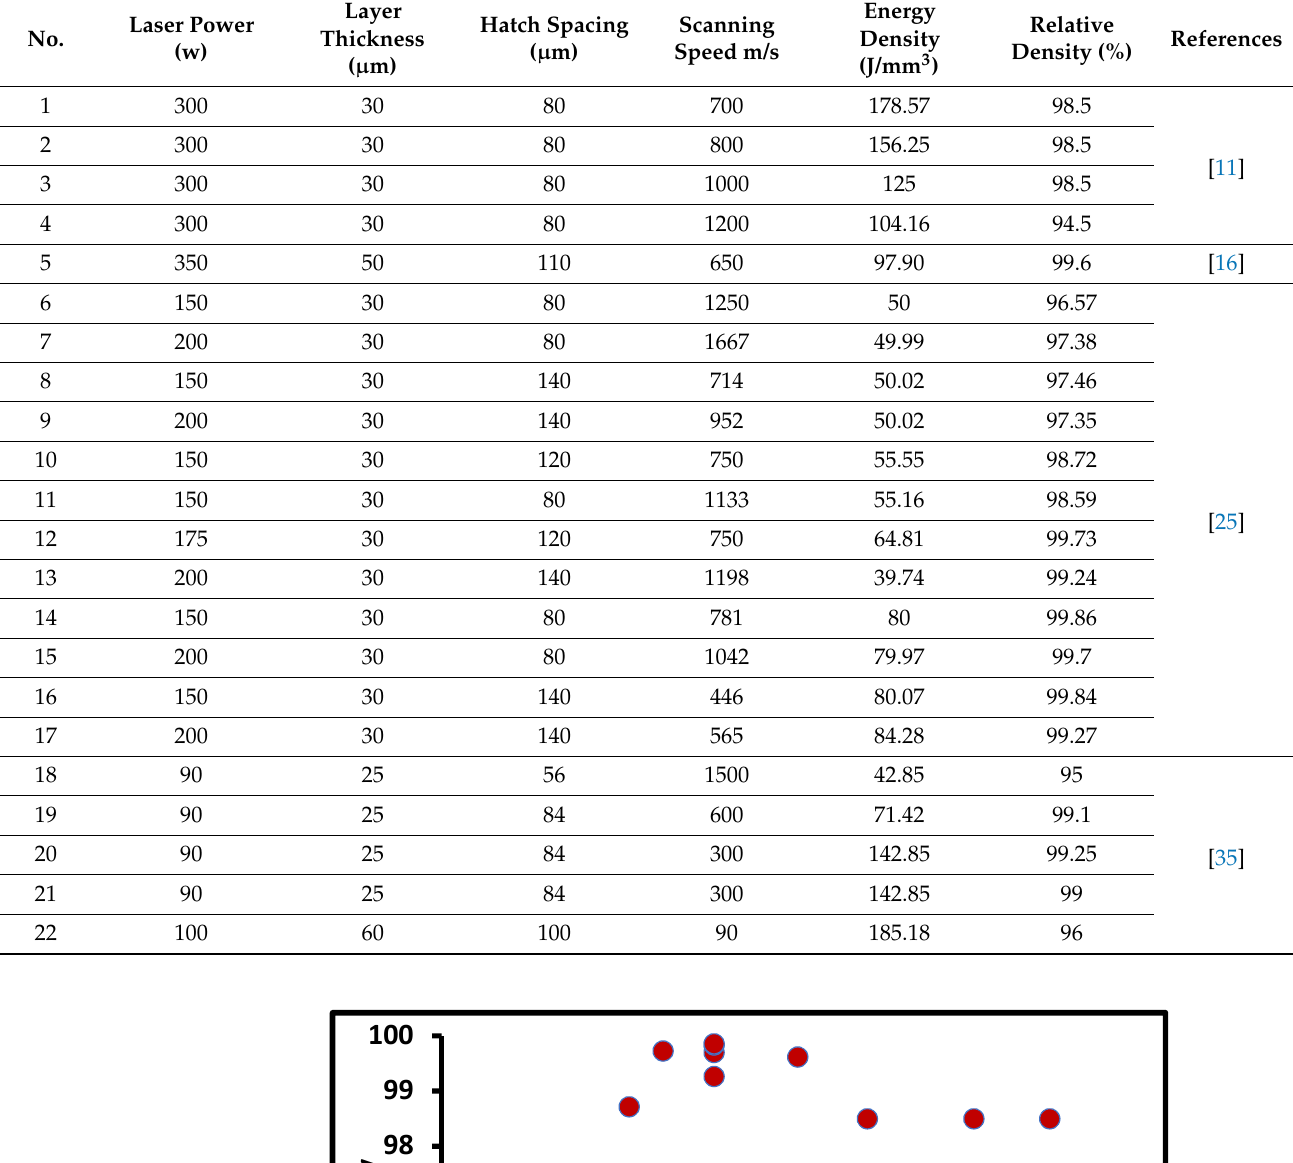
Table 3. Effect of different process parameters on relative density (as-built).